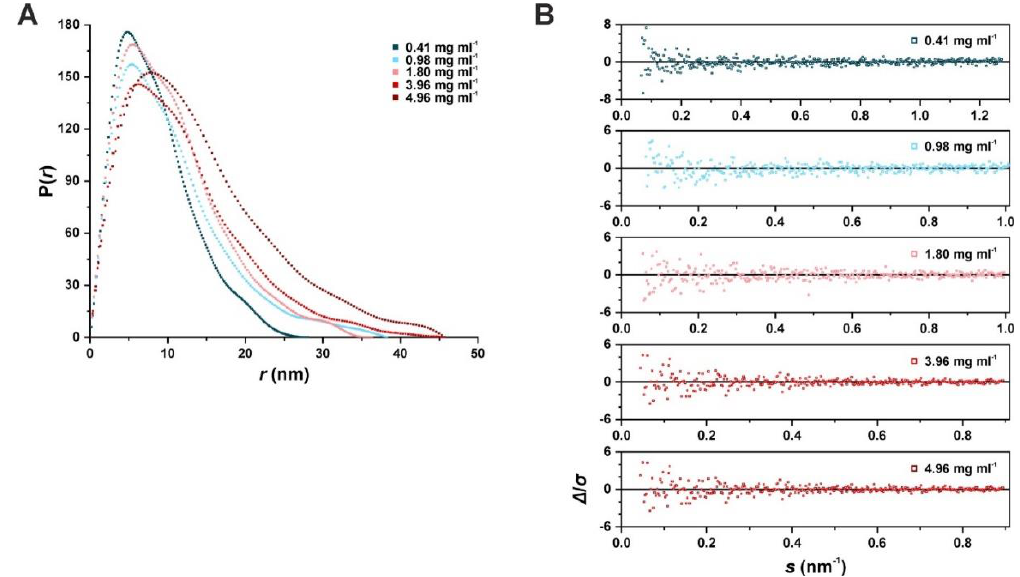
Figure 5. Radius distributions of SAUL1 in the batch measurement. ( A ) P( r ) versus r profile of SAUL1 at different concentrations. ( B ) Plot of the different standardized residuals of the fits of the P( r ) functions against the scattering data.